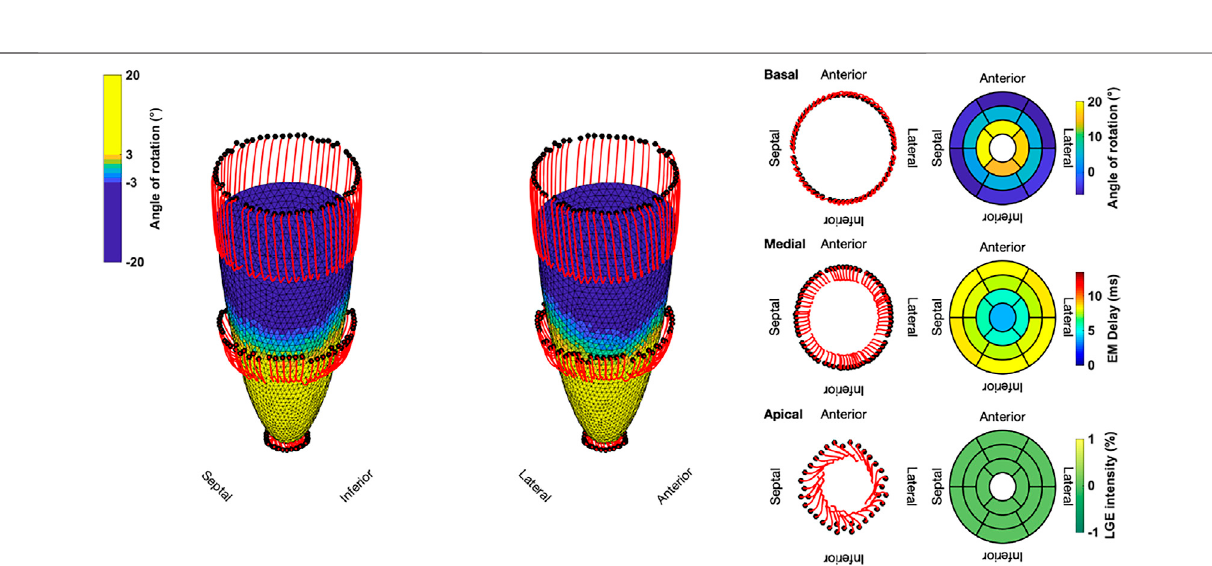
FIGURE 3 | Rotational dynamics of the basal and apical segments during one whole heart beat (left panel) and sectorial mean end-systolic rotation angle (right panel). The Control case is shown on the top and represents wringing rotation. Case 18 is shown on the bottom and was classi fi ed as RBT rotation.